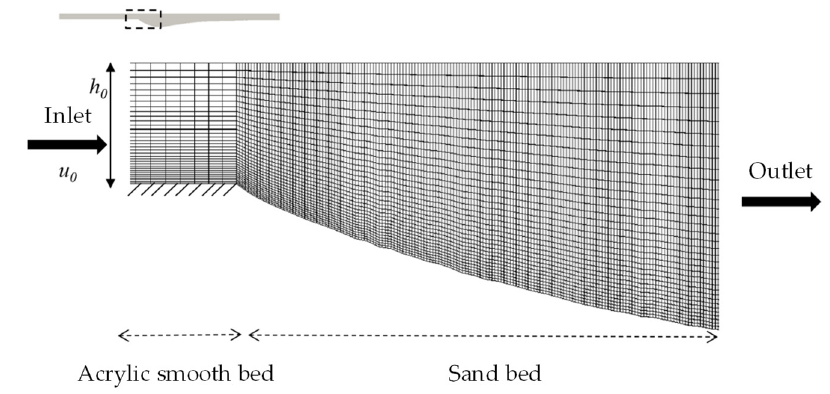
Figure 2. Schematic model setup and mesh grid (not to scale).